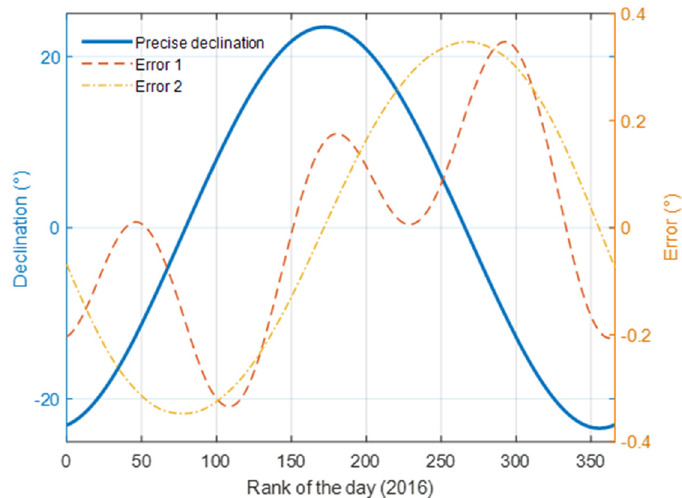
Figure 5. Comparison between Equations (5) and (6) and IMMCE calculation to choose the Sun’s declination equation.